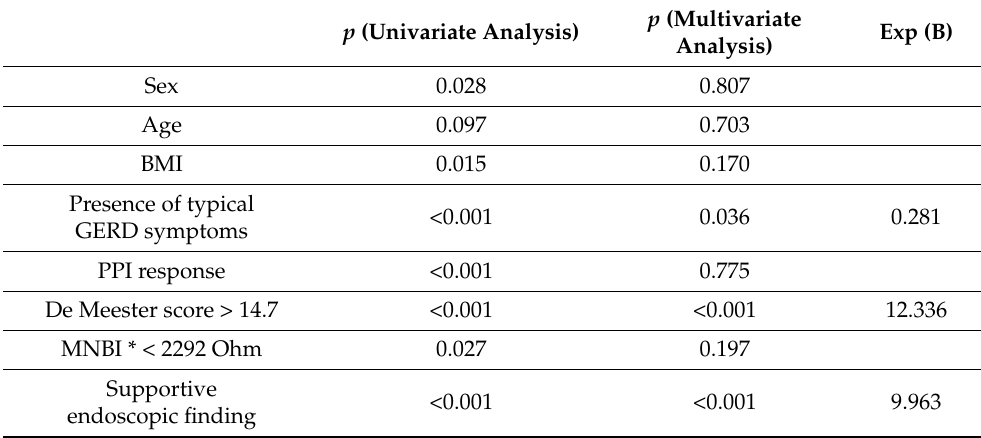
Table 3. Multivariate analysis of factors correlated to GERD